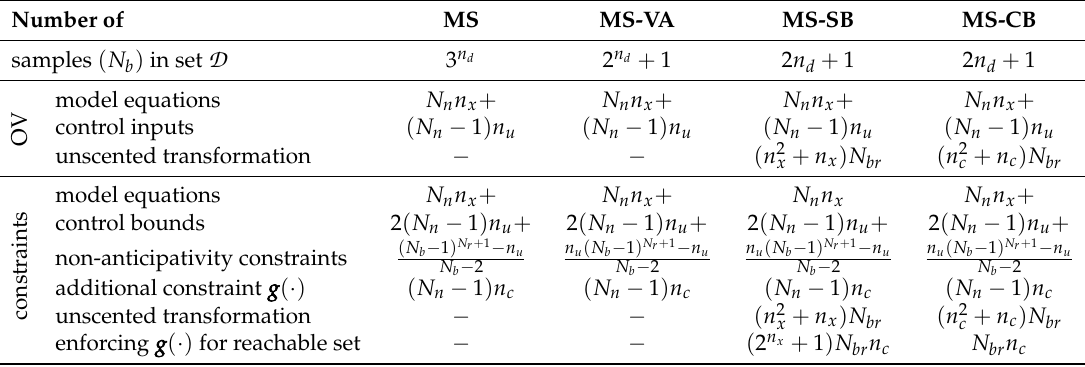
Table 1. A complexity comparison of different robust multi-stage NMPC optimization problem. N br and N ar represent the number of nodes considered in the scenario tree for k < N r and for N r